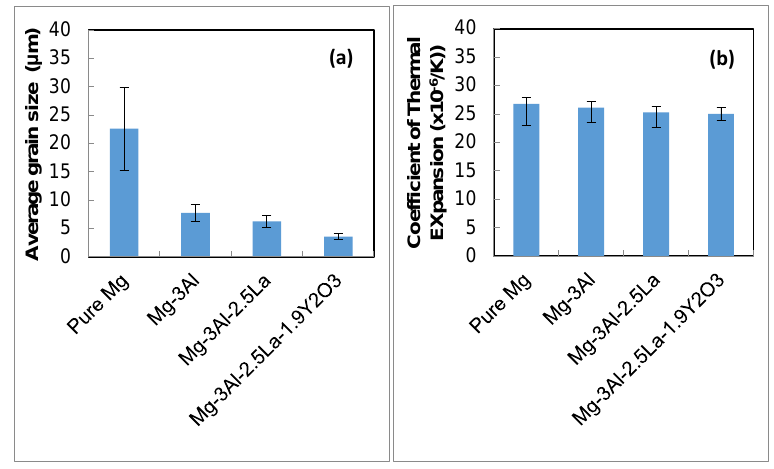
Figure 2. Change in ( a ) grain size and ( b ) coefficient of thermal expansion in pure Mg with the addition of 3Al, 2.5La and 1.9Y 2 O 3 subsequently.